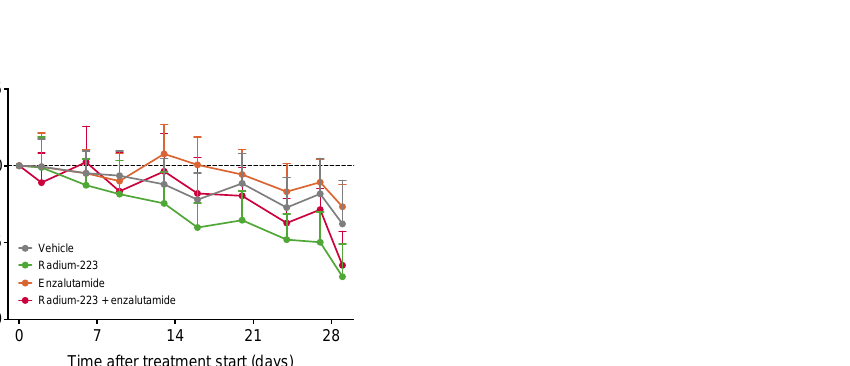
efficacy in vivo . Blood samples were collected from the saphenous vein of mice ( n = 9/group)